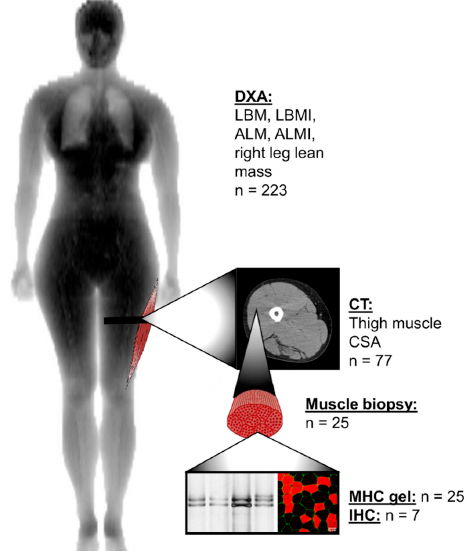
Figure 1 . Anatomical levels of lean and muscle mass measurements and the number of the same participants measured at baseline and final follow-up time-points. ALM, appendicular lean mass; ALMI, appendicular lean mass index; CSA, cross-sectional area; CT, computed tomography; DXA, dual-energy X-ray absorptiometry; IHC, immunohistochemistry; LBM, lean body mass; LBMI, lean body mass index; MHC, myosin heavy chain.